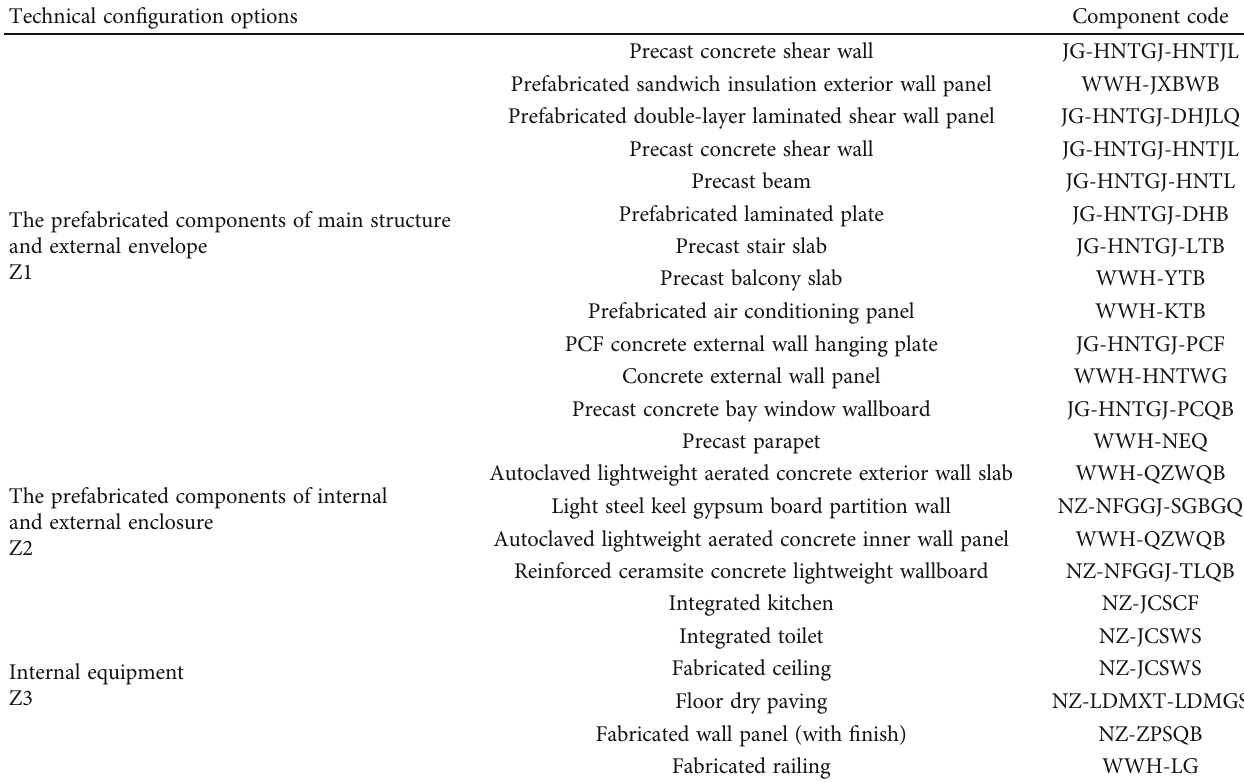
Table 1: Prefabricated residential component